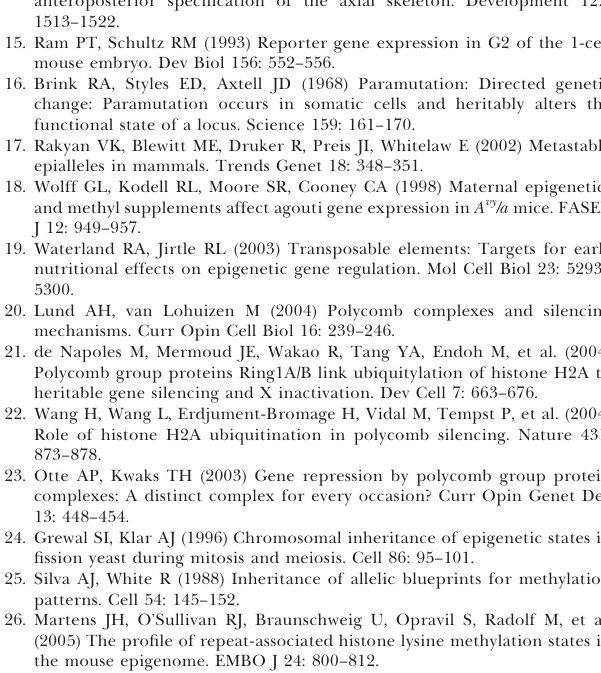
Figure S2. Bisulfite Analysis of Methylation of the A vy Allele in 12.5- dpc